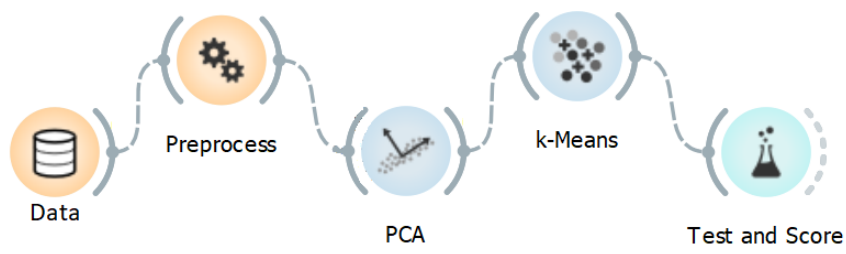
Figure 2. Typical data pipeline for SKU